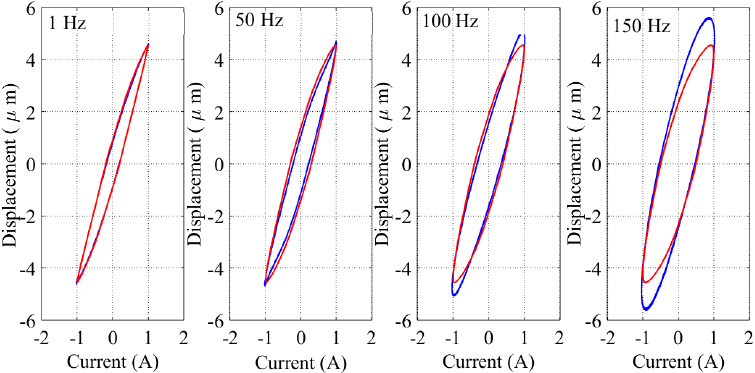
Figure 10. Comparisons of major-loop output-input responses between the proposed model and the measured data with load (16kg). (Fre- quencies in 1, 50, 100 and 150Hz and excitation amplitude 1A, blue line – measured data; red line – proposed